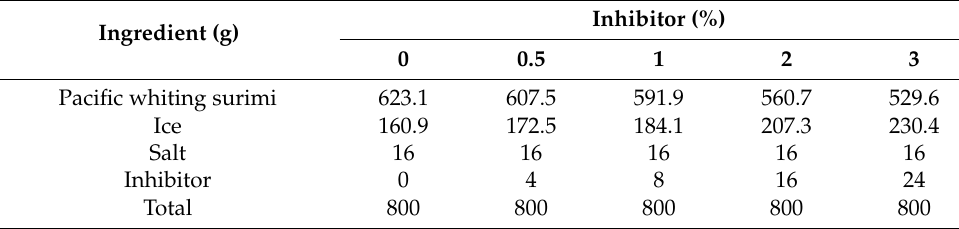
Table 1. Formulation of the PW surimi gels containing